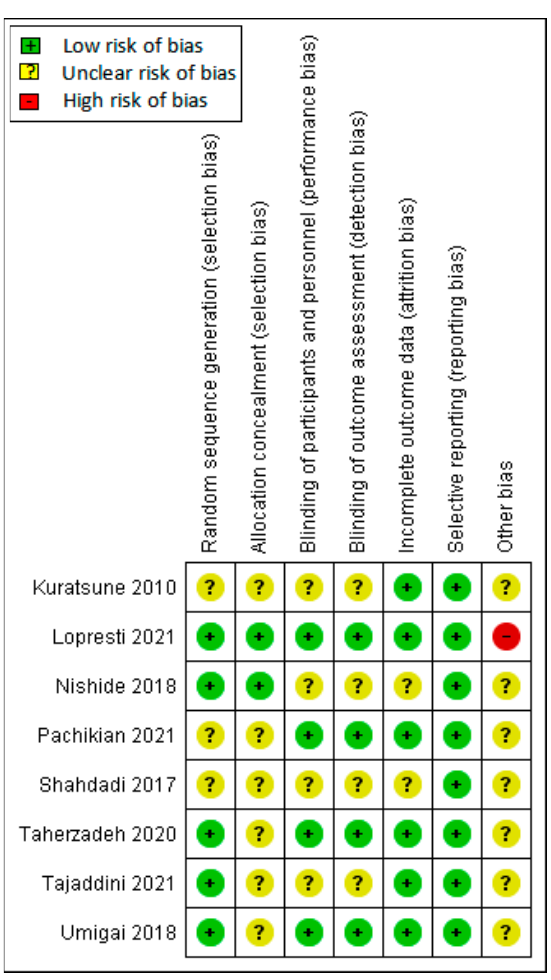
Figure 2. Judgement about each risk of bias item presented as percentages across all included studies.